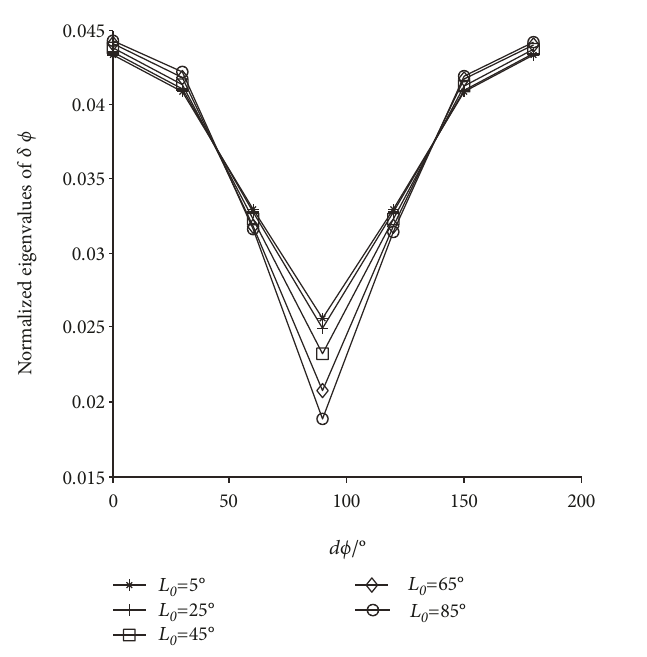
Figure 4: Normalized eigenvalues of the heading angle error δϕ as initial latitude